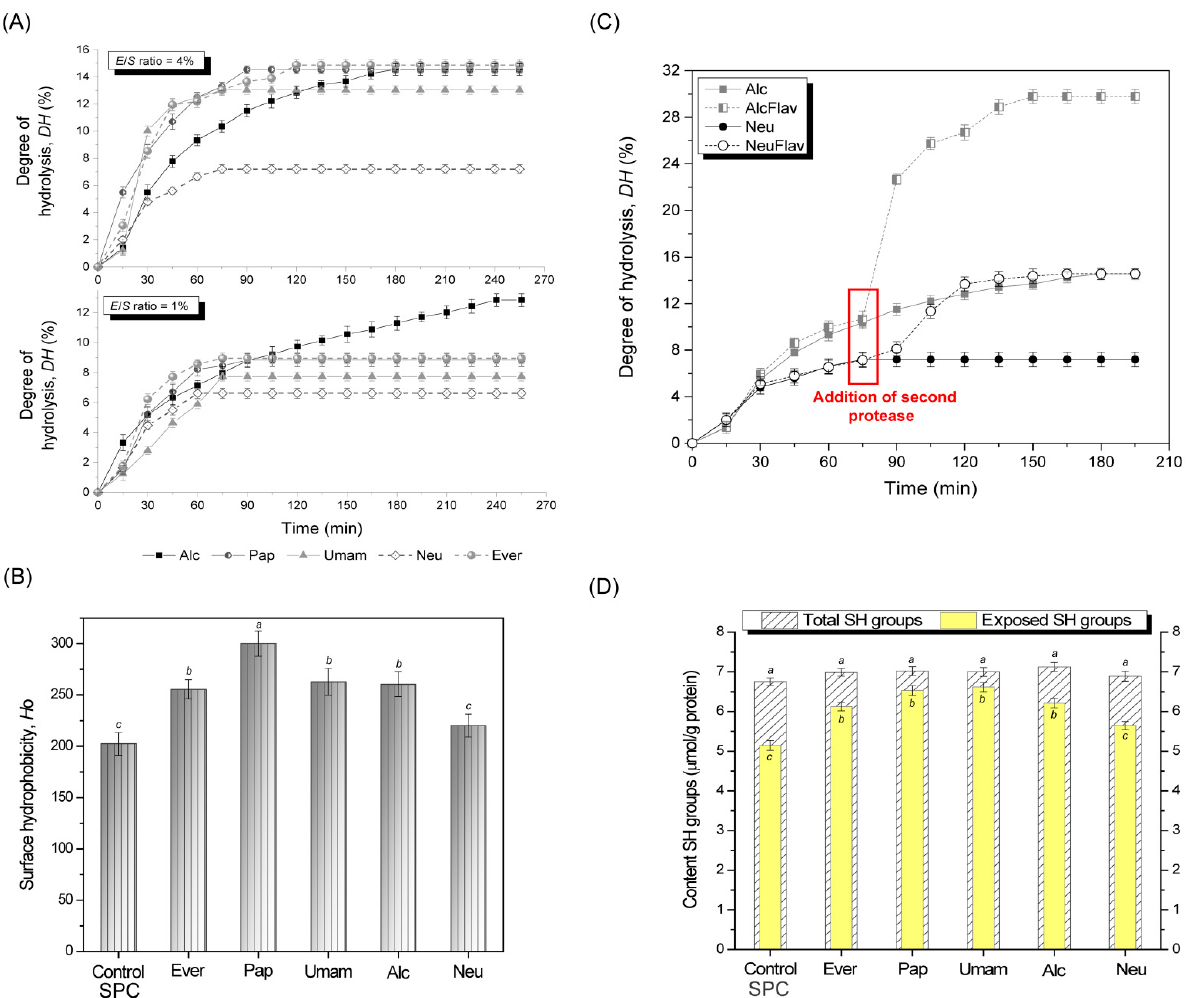
Figure 1. Kinetics of SPC hydrolysis with ( A ) Alcalase, Neutrase, papain, Everlase and Umamizyme alone at two E / S ratios; and ( B ) with Alcalase or Neutrase (added at time 0 min) and Flavourzyme (added after 75 min) in the two-step enzymatic process; ( C ) surface hydrophobicity and ( D ) content of SH groups of SPC (control) and hydrolysates prepared with different enzymes. Data correspond to the average SD of three ( A , B ) and two ( C , D ) determinations. Results are expressed as means ± standard deviation (n = 2 (for graphs A , B ) and n = 3 (for graphs C , D )). Means with different lower letters in the same graph are significantly different ( p <